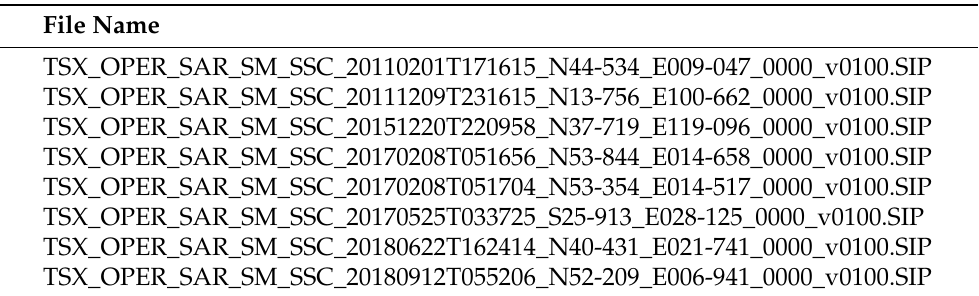
Table A2. File name list of the downloaded TerraSAR-X